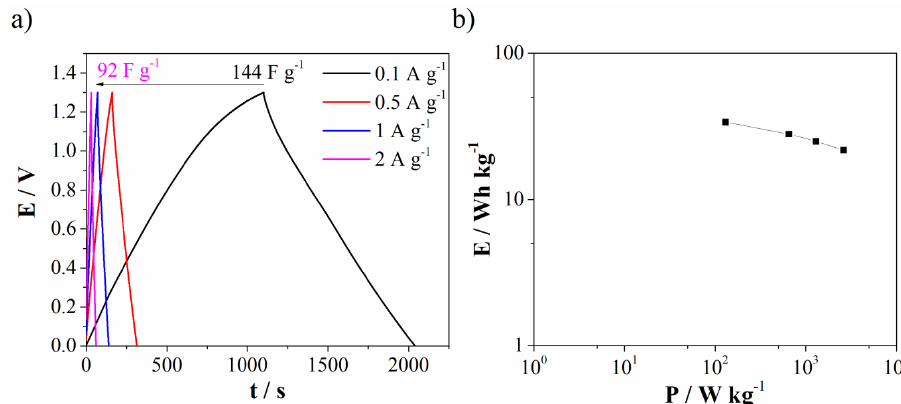
Figure 11. ( a ) GCD curves at different current density for Mn 3 O 4 @N-doped carbon in Al 3+ -Ca 2+ mixture electrolyte and ( b ) Ragone plot.